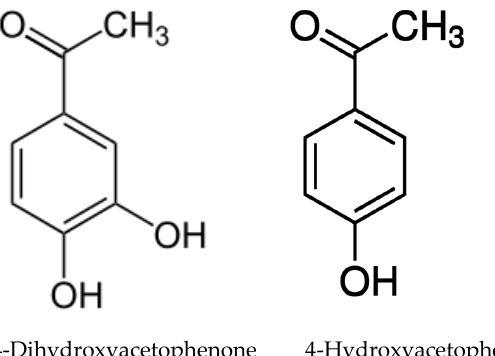
Figure 12. Allelochemicals of Picea species .